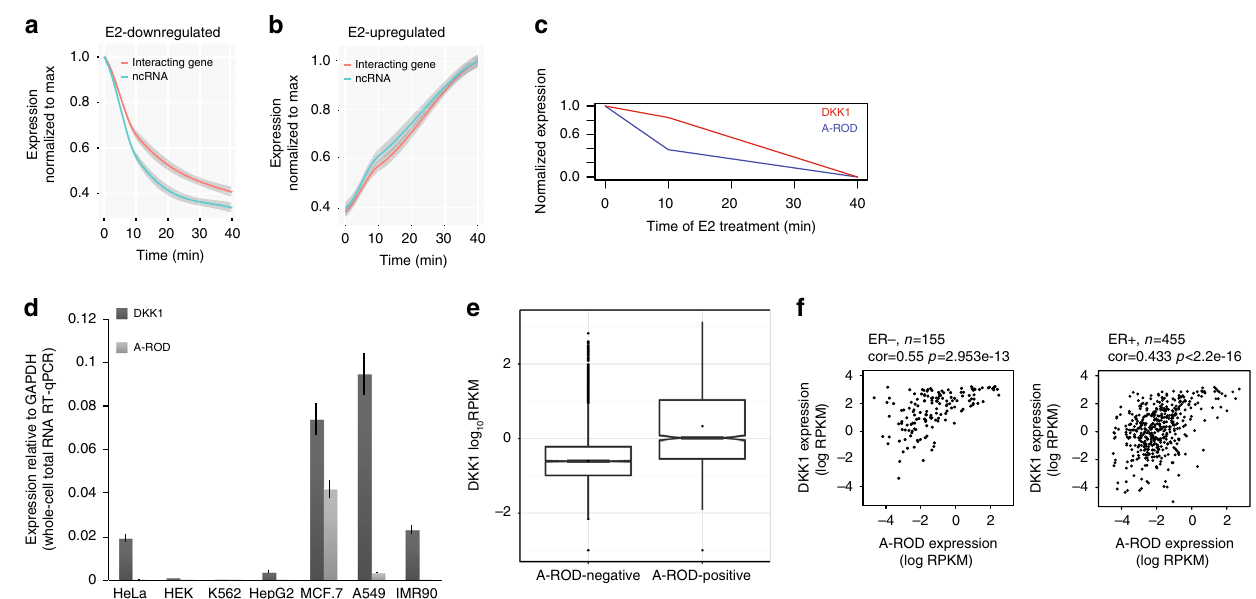
Fig. 2 Expression of interacting long ncRNA-target gene pairs. a E2 mediated response for downregulated long ncRNA-interacting gene pairs ( n = 419 with ChIA-PET interaction score > 200). Expression is normalized to maximum, i.e., GRO-seq 35 RPKM from 10 and 40 min of E2 treatment are normalized to 0 h (EtOH control). Fitted regression model lines (loess curves) are drawn. The 95% con fi dence region is grey shaded. b Same as in ( a ), but for the E2- upregulated long ncRNA-gene pairs ( n = 512, ChIA-PET interaction score > 200). Expression is normalized to maximum, i.e., to the 40 min E2-treatment GRO-seq RPKM. c A-ROD and DKK1 expression as a time response to E2 induction. GRO-seq RPKM from 0 h (EtOH control), 10 and 40 min of E2 treatment were rescaled in the range 0 to 1 using min – max normalization. d Expression of A-ROD and DKK1 measured by RT-qPCR across seven cell lines, normalized to GAPDH. e Expression of DKK1 in A-ROD – positive ( n = 1659) and A-ROD – negative tissue-samples ( n = 6896) using GTEx data. Wilcoxon- Mann-Whitney test p -value < 2.2e-16. f Correlation of A-ROD and DKK1 expression (total exon RPKM in log scale) in ER positive and ER negative breast cancer samples. Data obtained from the Cancer Genome